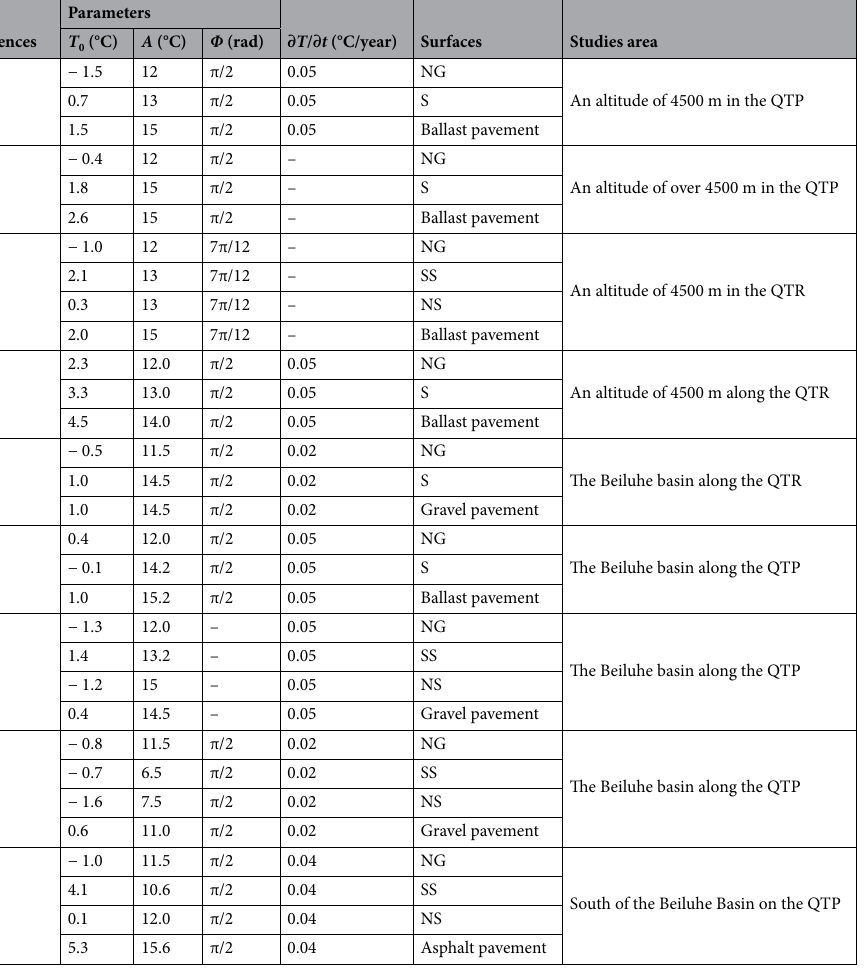
Table 3. A list of T 0 and A which have been used in simulated temperature of permafrost. “–” do not be measured, NG natural ground surface, S side slope, SS south-facing side slope, NS north-facing side slope, QTR Qinghai-Tibet Railway, QTP Qinghai-Tibet